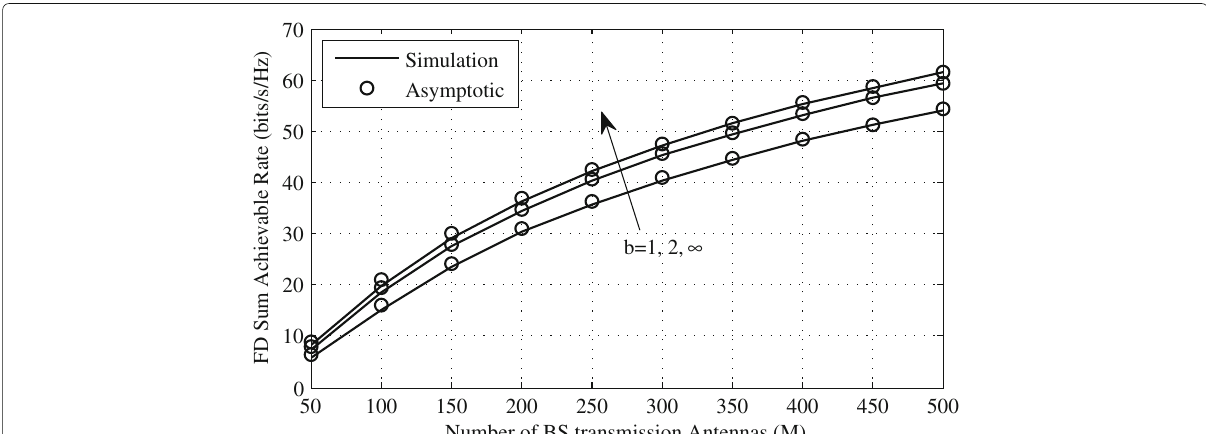
Fig.2 FDsumratefordifferent b .ComparisonofFDsumrateforthedifferentnumbersofquantizationbits b versusthenumber ofantennasatthe BS